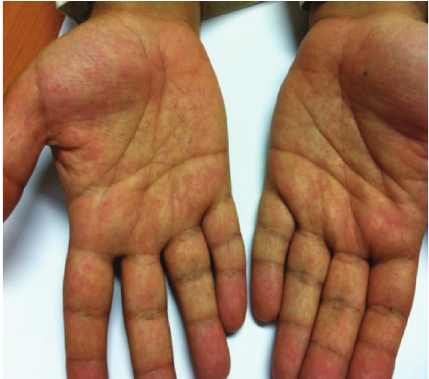
Figure 1: Numerous palmar pits in a patient with Gorlin-Goltz syndrome.